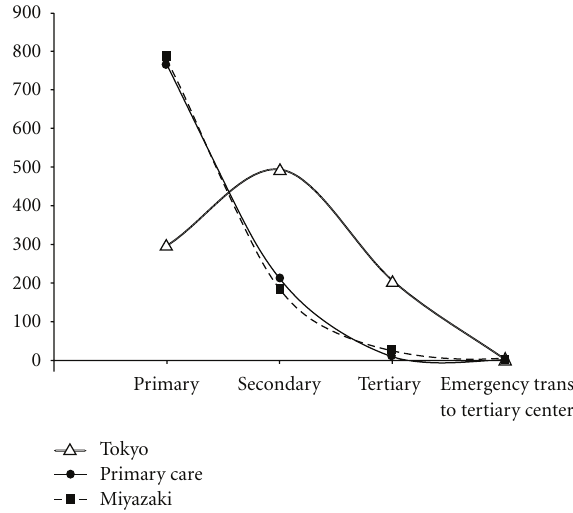
Figure 1: Ecology curves showing the relationship between patient number per 1,000 as a function of perinatal care levels. There is similarity between the combined original ecology curve (solid) and that for Miyazaki data (dotted). However, the curve derived from the Tokyo data (doublet) is apparently di ff erent from the original